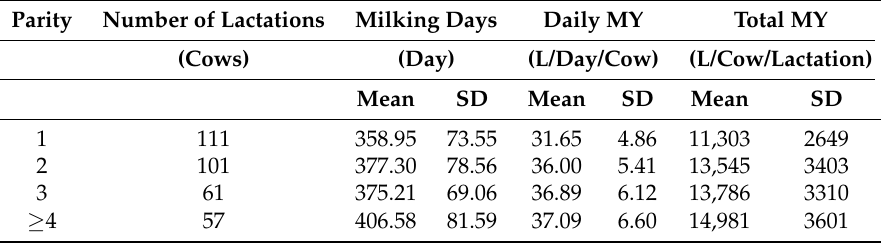
Table 2. Lactation statistics for the filtered data according to each